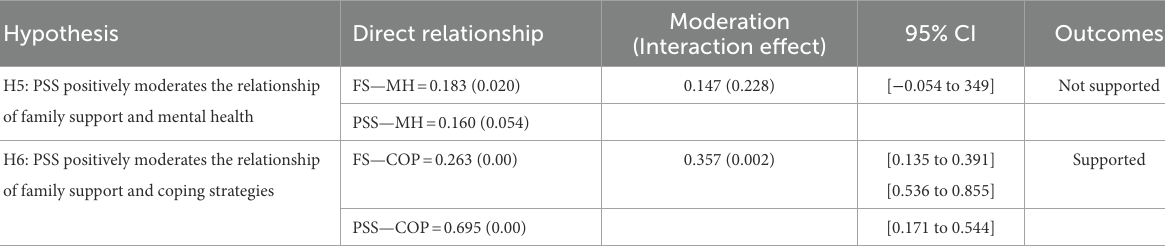
TABLE 8 Hypothesis testing for moderation